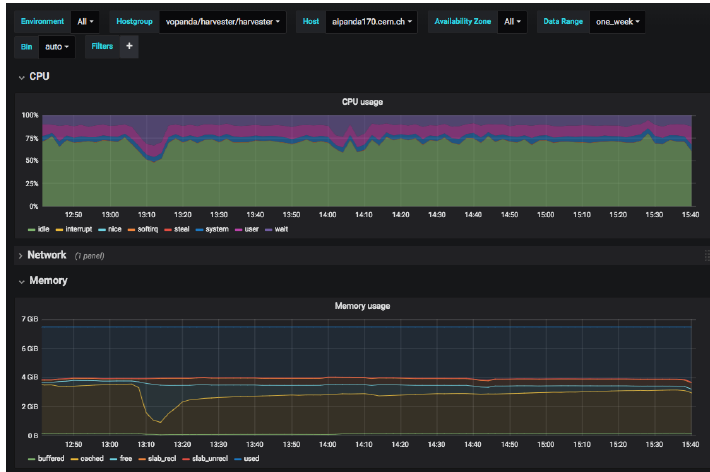
Figure 4. Grafana dashboard showing system